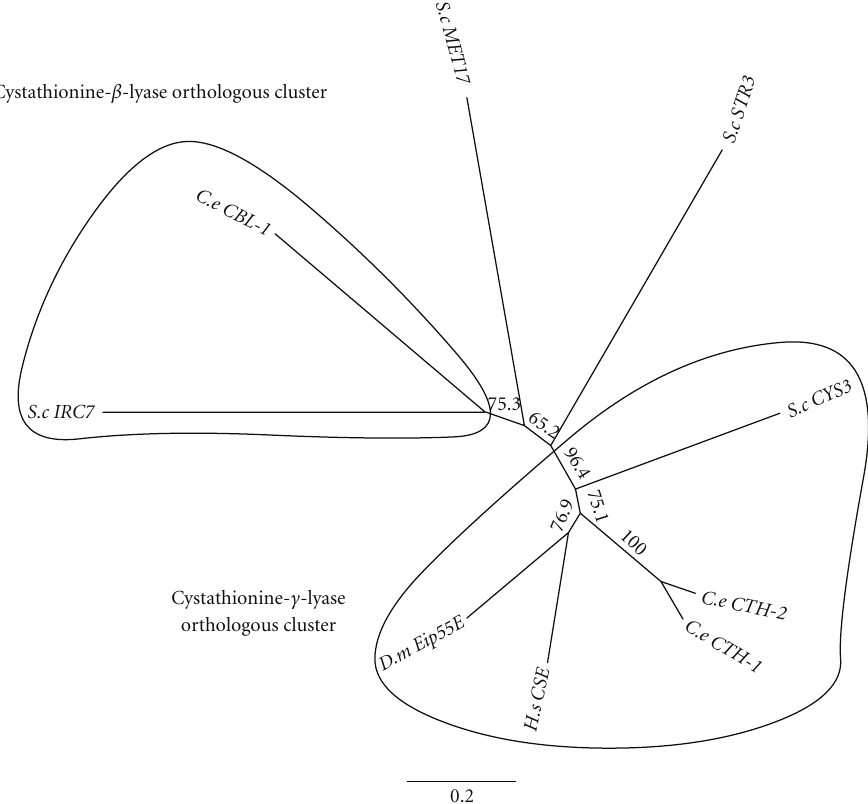
Figure 3: Phylogenetic tree analysis of cystathionine- γ -lyase and Cystathionine- β -lyase (CBL). F22B8.6 (CTH-1/CSE-1), ZK1127.10 (CTH- 2/CSE-2), and C12C8.2 (CBL). See Figure 2 for details on the phylogenetic